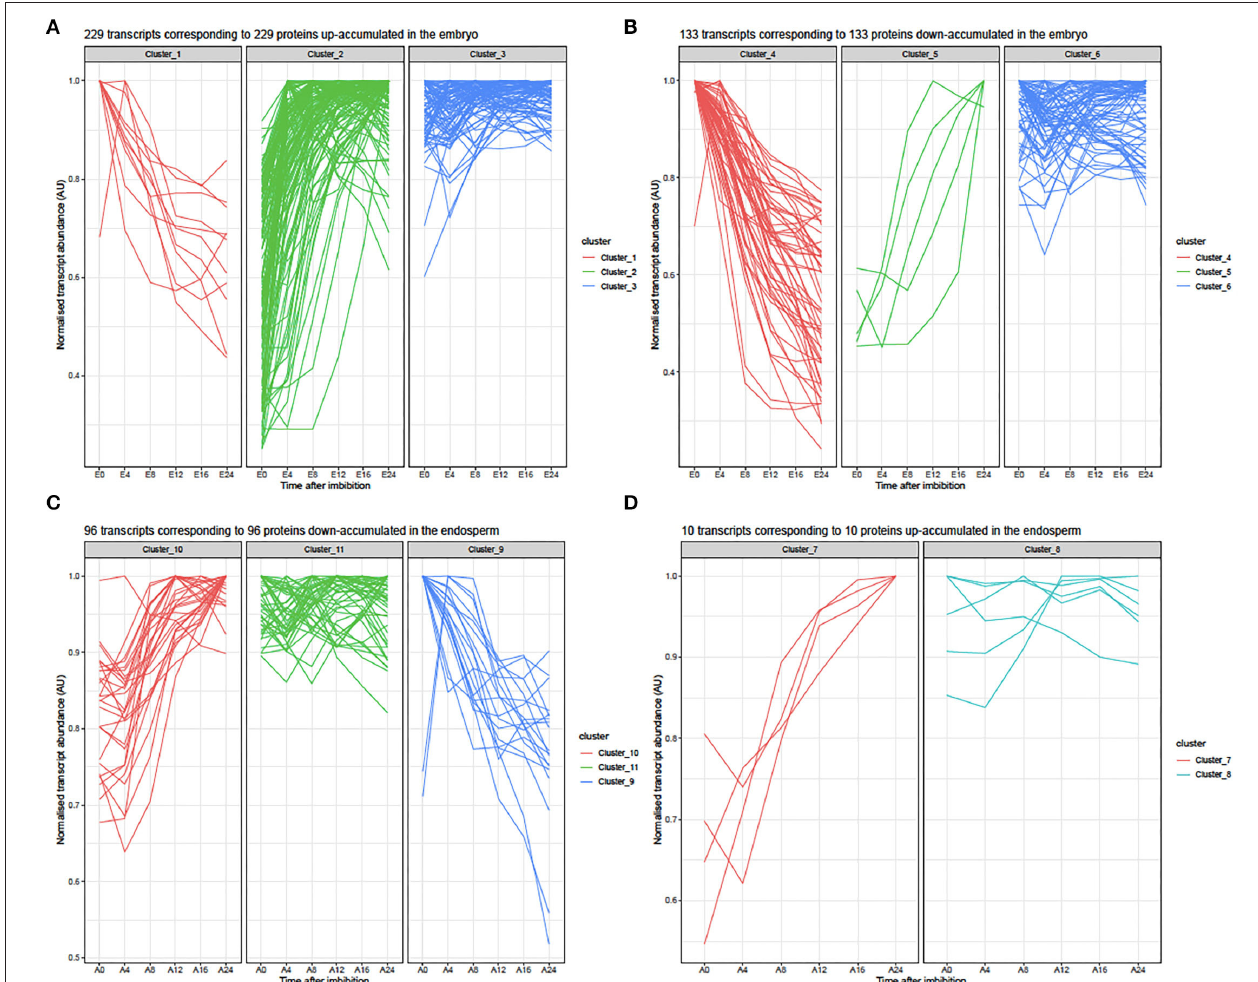
FIGURE 4 | Line plots of transcripts corresponding to embryo or endosperm with significant contrasted accumulations between 0 and 24 HAI. (A) Normalized abundances of 229 transcripts detected in the embryo during rice seed germination time course corresponding to 229 proteins up-accumulated at 24 HAI. From the shotgun proteome, 256 up-accumulated proteins were detected, of which only 229 showed changes in the corresponding mRNA abundances. In the embryo transcriptome data, the corresponding mRNA abundance was normalized by their corresponding maximum intensities reached during germination to yield accumulation values comprised between 0 and 1. E, Embryo; E0, dry embryos, E4-E24, dissected embryos from whole rice seed imbibed 4, 8, 12, 16, and 24 HAI. Clusters 1, 2, and 3 are described in Supplementary Table S5B . (B) Normalized abundances of 133 transcripts detected in the embryo during the rice seed germination time course corresponding to 133 proteins down-accumulated at 24 HAI. The shotgun proteome evidenced 152 down-accumulated proteins ( Supplementary Table S5C ). From the embryo transcriptome data, the corresponding mRNA abundances were normalized by their maximum intensities reached during germination to yield accumulation values comprised between 0 and 1. E, Embryo; E0, dry embryos; E4-E24, dissected embryos from whole rice seed imbibed for 4, 8, 12, 16, and 24 HAI. Clusters 4, 5, and 6 are described in Supplementary Table S5D . (C) Normalized abundances of 96 transcripts detected in the endosperm during rice seed germination time course corresponding to 96 proteins down-accumulated at 24 HAI. From the shotgun proteome, 109 were down-accumulated proteins at 24 HAI and corresponded to these 91 transcripts ( Supplementary Table S5G ). From the endosperm transcriptome data, corresponding mRNA abundances were normalized by their corresponding maximum intensities reached during germination to yield accumulation values comprised between 0 and 1. A, Endosperm; A0, dry endosperm; A4-A24, dissected endosperms from whole rice seed imbibed 4, 8, 12, 16, and 24 HAI. Clusters 9, 10, and 11 are described in Supplementary Table S5H . (D) Normalized abundances for 10 transcripts detected in the endosperm during rice seed germination time course corresponding to 10 proteins up-accumulated at 24HAI. From the shotgun proteome, 11 were up-accumulated proteins at 24 HAI and corresponded to these 10 transcripts detected in our transcriptome data ( Supplementary Table S5F ). From the endosperm transcriptome data, the corresponding mRNA abundances were normalized by their corresponding maximum intensity reached during germination to yield accumulation values comprised between 0 and 1. A, Endosperm; A0, dry